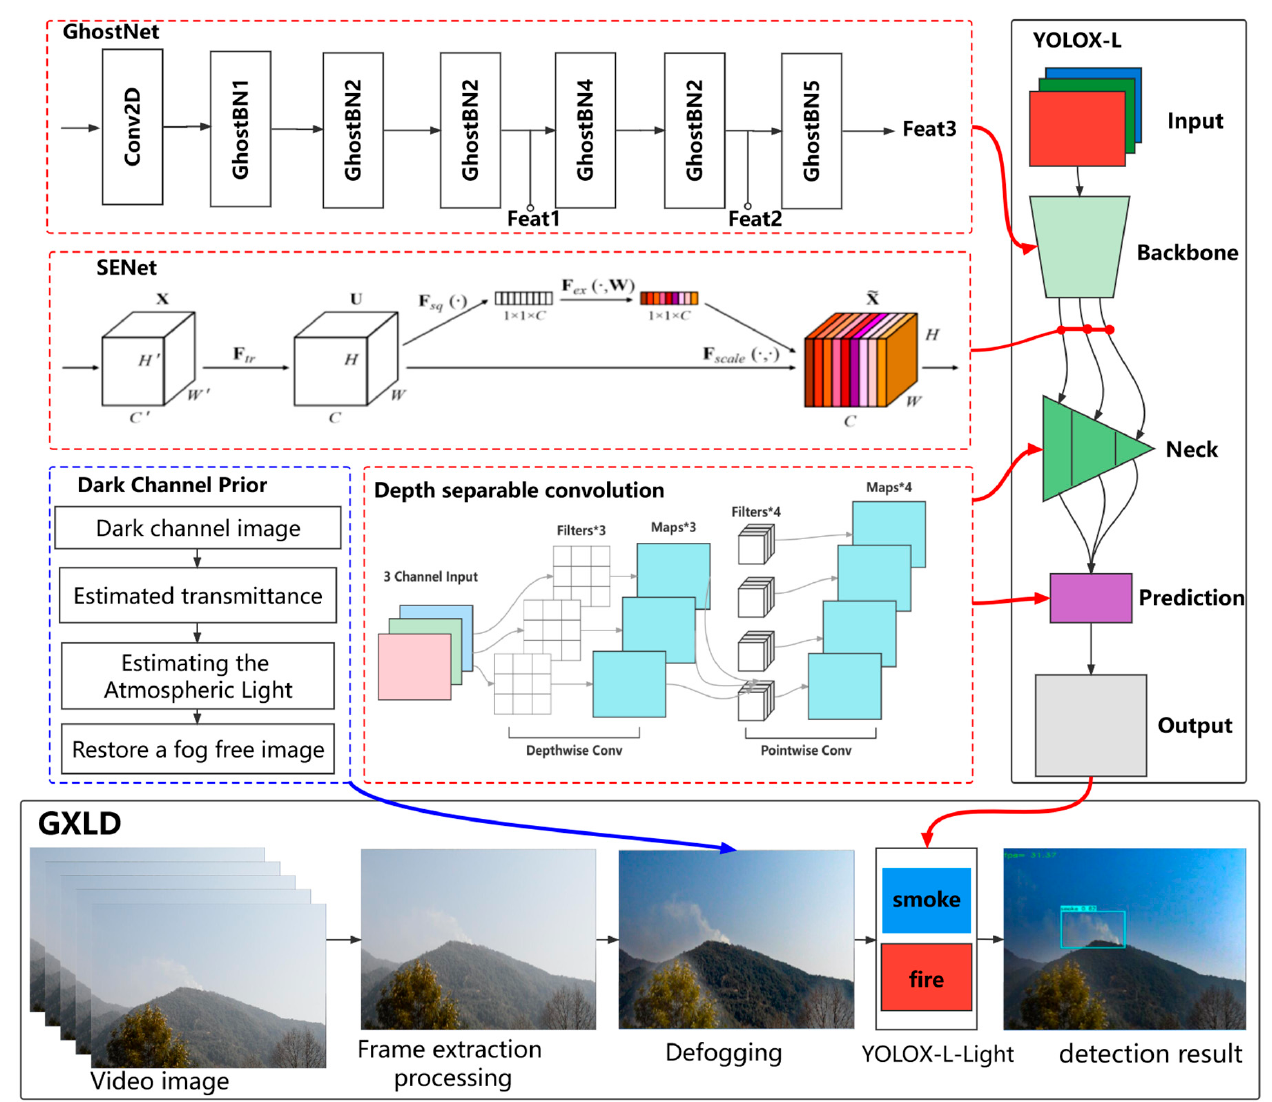
Figure 4. Overall design process of GXLD, including GhostNet network structure, SENet structure, DCP defogging process, and YOLOX-L network structure.